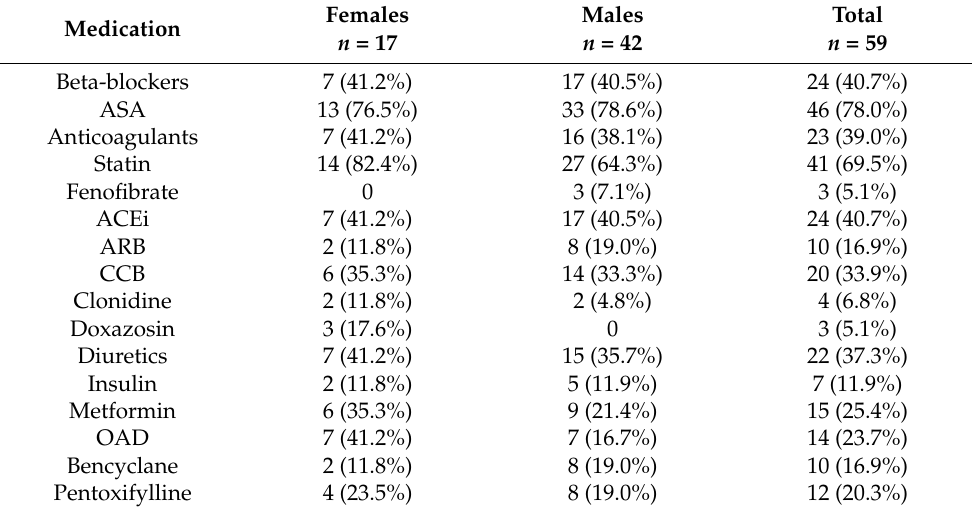
Table 2. Medications taken by the patients with peripheral artery disease